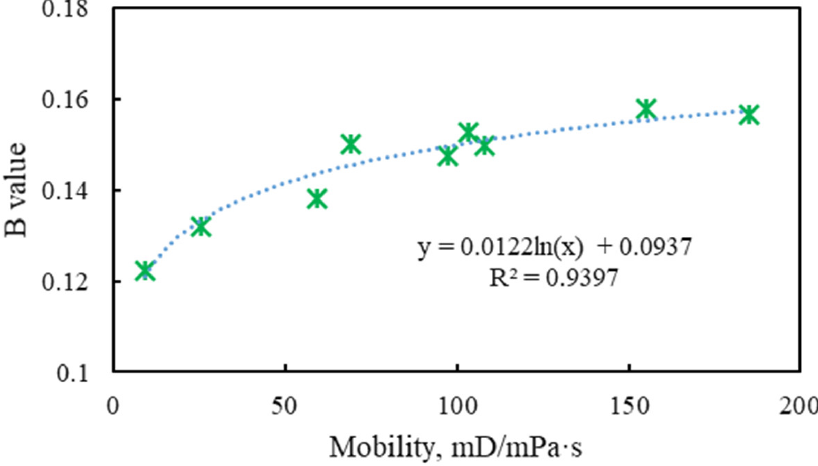
Figure 8. The relationship between the value of coefficient B and mobility.